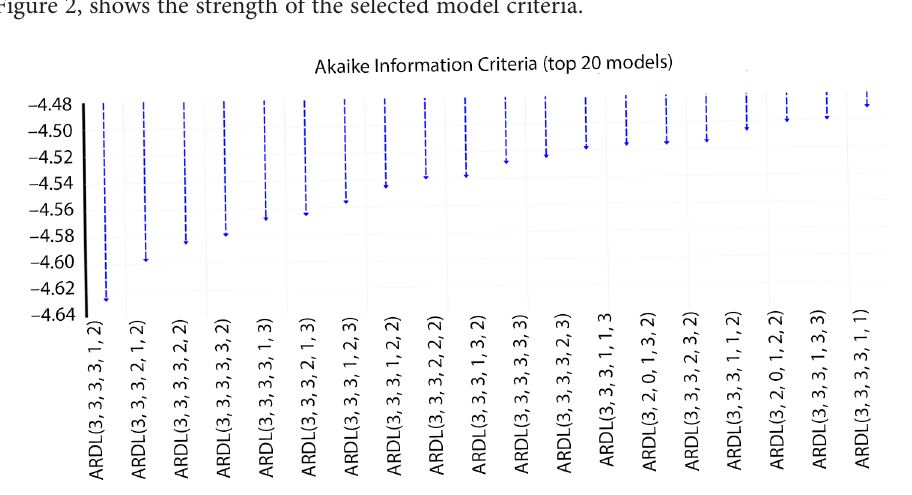
Figure 2. The strength of model selection criteria Table 2. Augmented-Dickey Fuller and Phillips-Perron